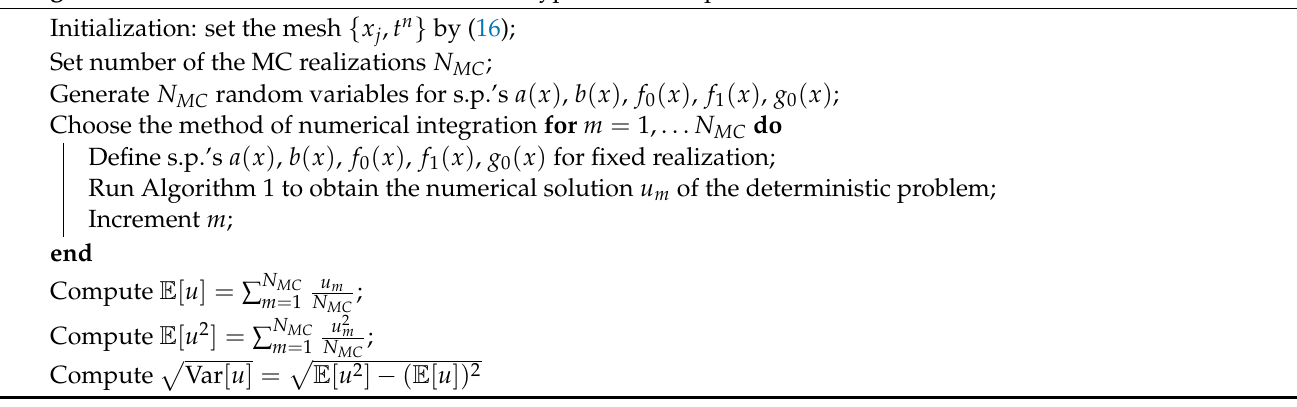
Algorithm 2: Numerical solution for random hyperbolic PDE